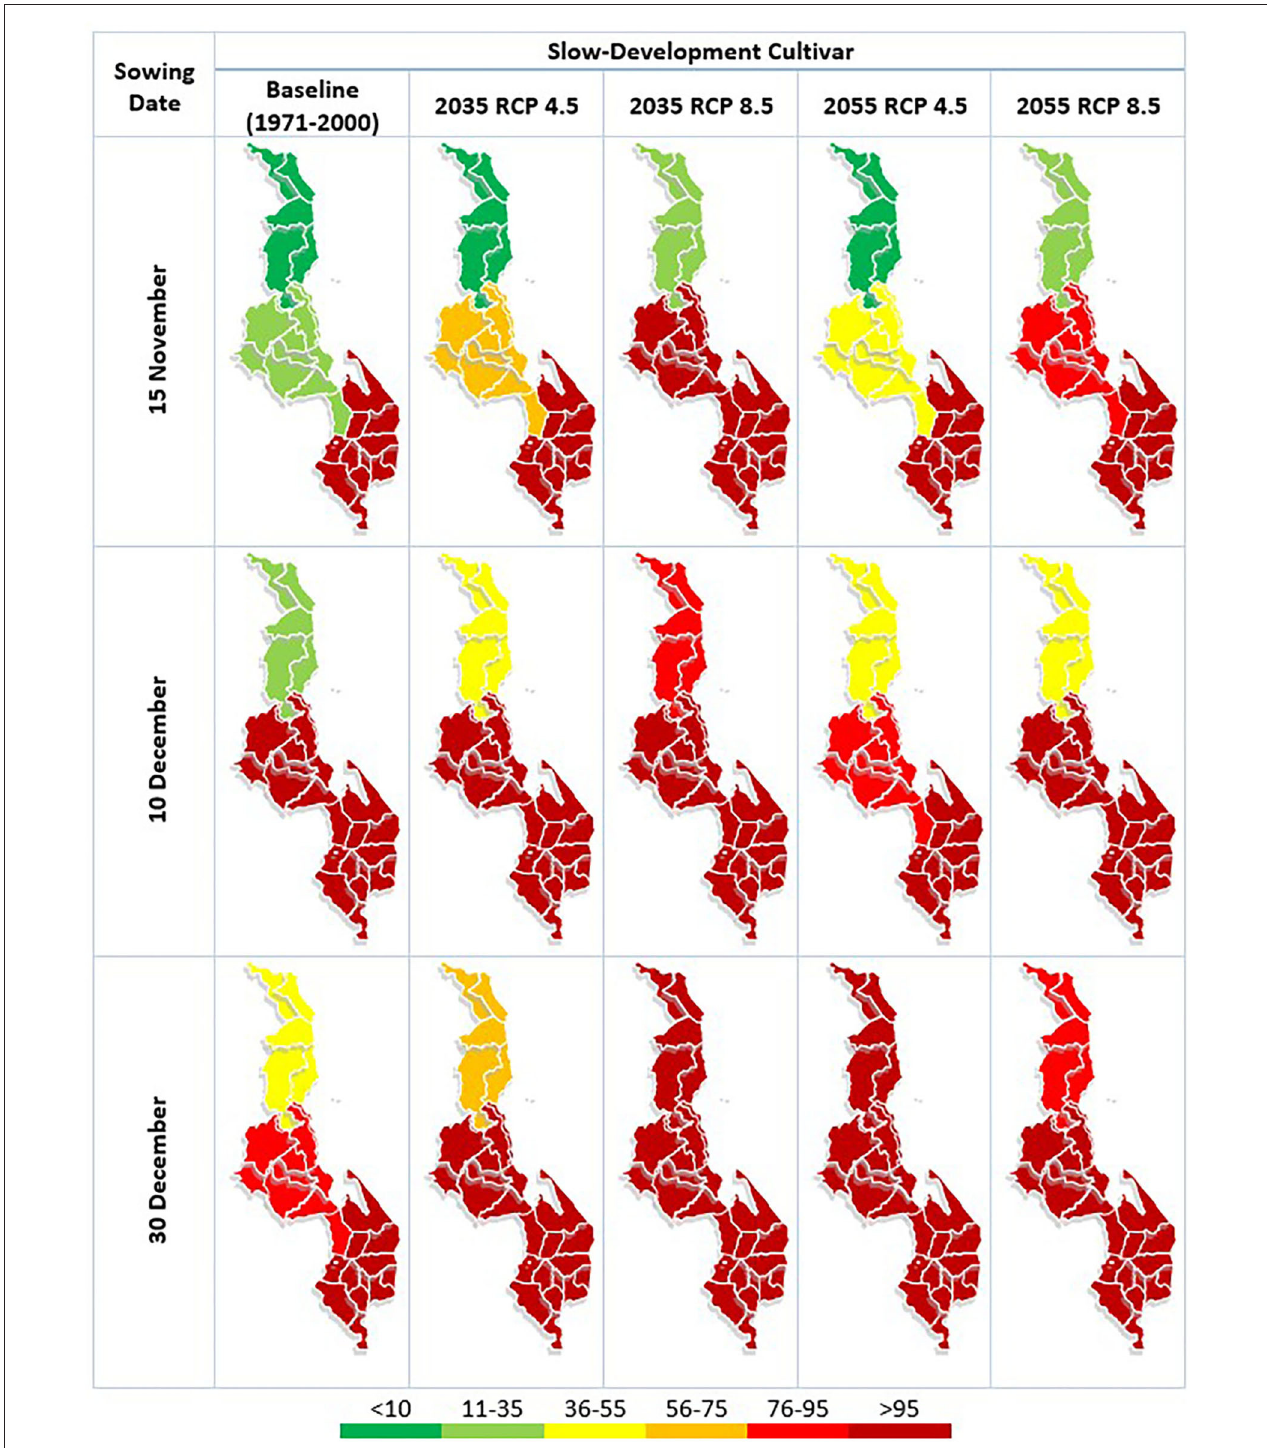
FIGURE 3 | AFI (Aflatoxin risk index) for slow-developing maize variety in each region of Malawi under differing climatic conditions and sowing dates. The first of the five rows represents the AFI under the baseline climate condition (1971–2000), the second and third row represent this risk associated with the 2035 (2020–2049) climate period under Representative Concentration Pathway (RCP) 4.5 and 8.5, respectively, and the final two rows represent this risk associated with the 2055 (2040–2069) climate period under RCP 4.5 and 8.5, respectively. The three columns represent the different sowing dates considered: 15 November, 10 December and 30th of December. The index at the bottom places the AFI results into color bands, with the deepest red indicating AFI levels which are consistent with exceedances of the EU threshold for AFB 1 (5 µ g/kg) contamination in food.